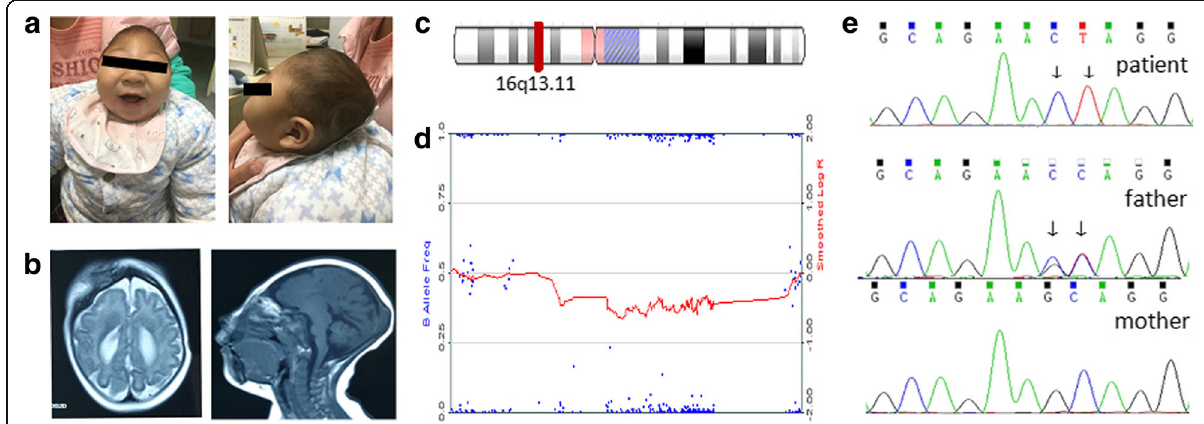
Fig. 1 The typical phenotype and laboratory results. The patient at 8 months of age showed severe microcephaly ( a ). MRI showed the agenesis of the corpus callosum, enlargement of the posterior lateral ventricles, and a simplified gyral pattern of the cerebral cortex ( b ). The Diagram of chromosome 16 and the 1.22 M microdeletion on 16p13.11 in the patient detected by CMA ( c and d ). The NDE1 sequence chromatogram of the patient and his parents, and arrows show the 2 base-pairs changes ( e